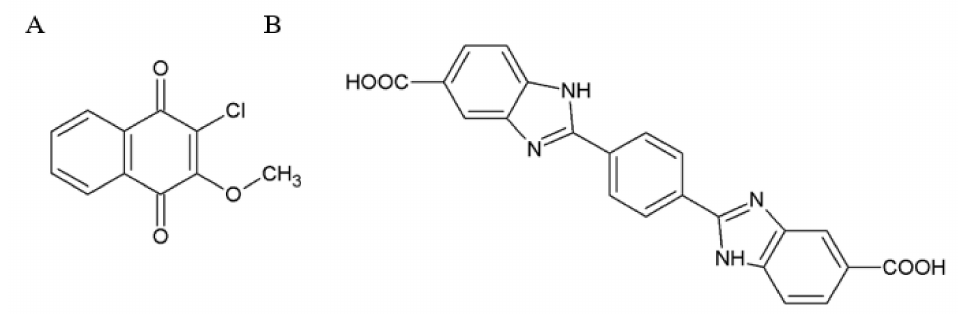
Figure 5. Chemical structures of GFR α / RET agonists from naphthoquinone ( A ) and benzimidazole ( B ) sca ff